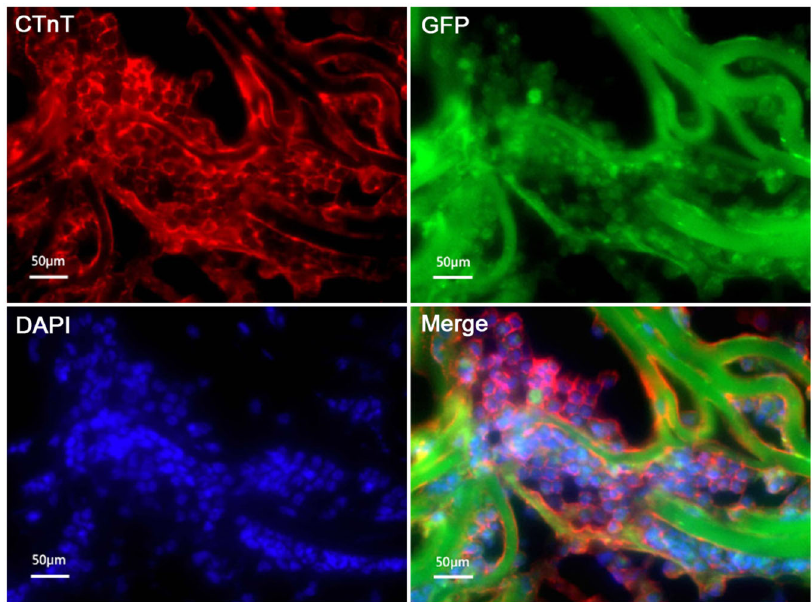
Fig. 4 cTnT expression of ADMSCs induced 3 weeks with 5-aza on 3D scaffolds by immuno fl uorescence staining. a Red shows cTnT; b green shows GFP; c blue shows the nucleus; d merge of a , b , and c . Bar = 50 μ m (color fi gure